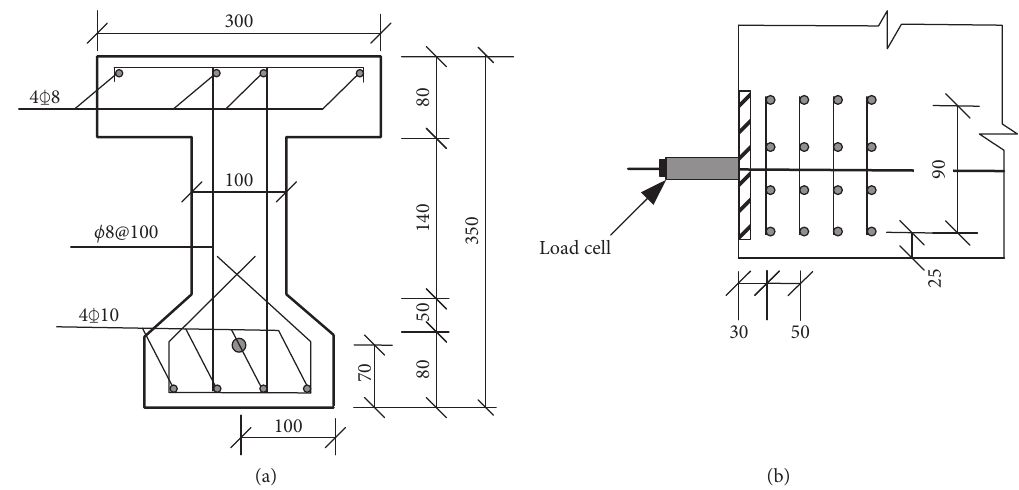
Figure 1: Configurations of the cross-section and the anchor end (unit: mm): (a) cross-section; (b) anchorage details. Table 2: Concrete age at tensioning and stress in prestressing tendons. Beam number Age of concrete at tensioning (days) Jacking